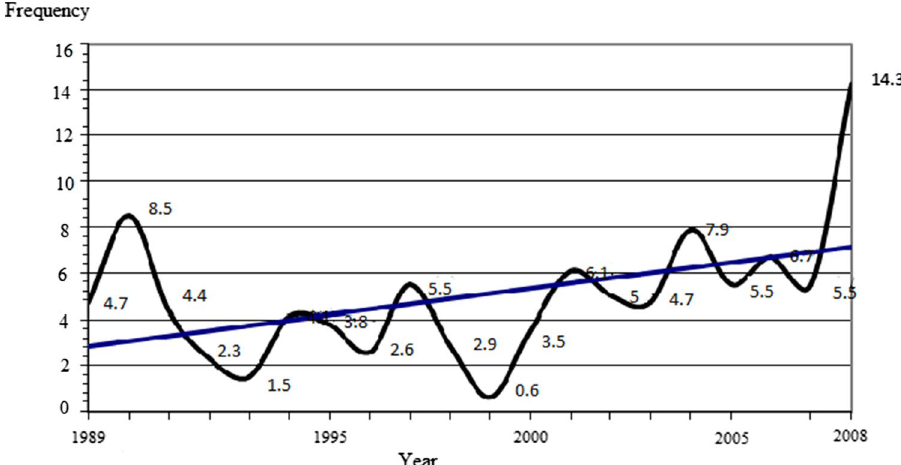
Fig. 6 Frequency percentage and annual trend of occurrence of dusty days in Sabzevar city during the statistical period of